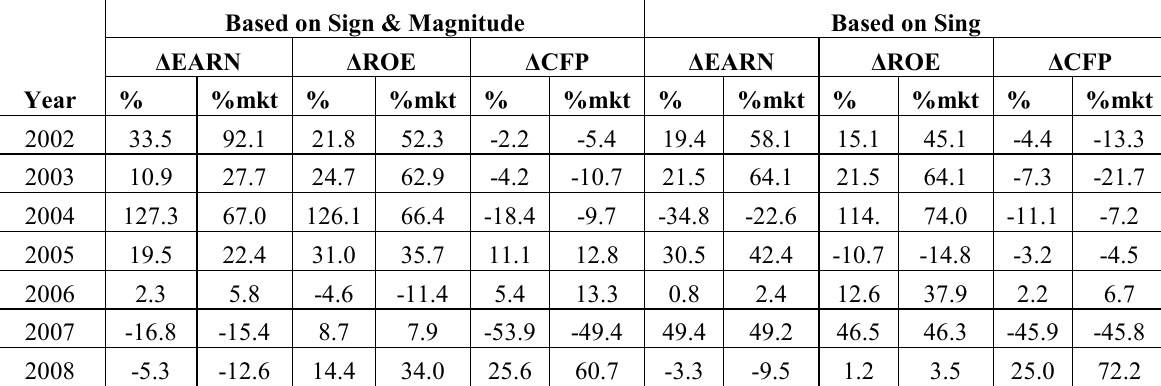
Table 3 Portfolio-Returns Approach Panel A: Mean market-adjusted returns on accounting hedge portfolio (%) and proportion of the total hedge portfolio market-adjusted returns can be earned by the per-knowledge of accounting information(%mkt)2002- 2008.